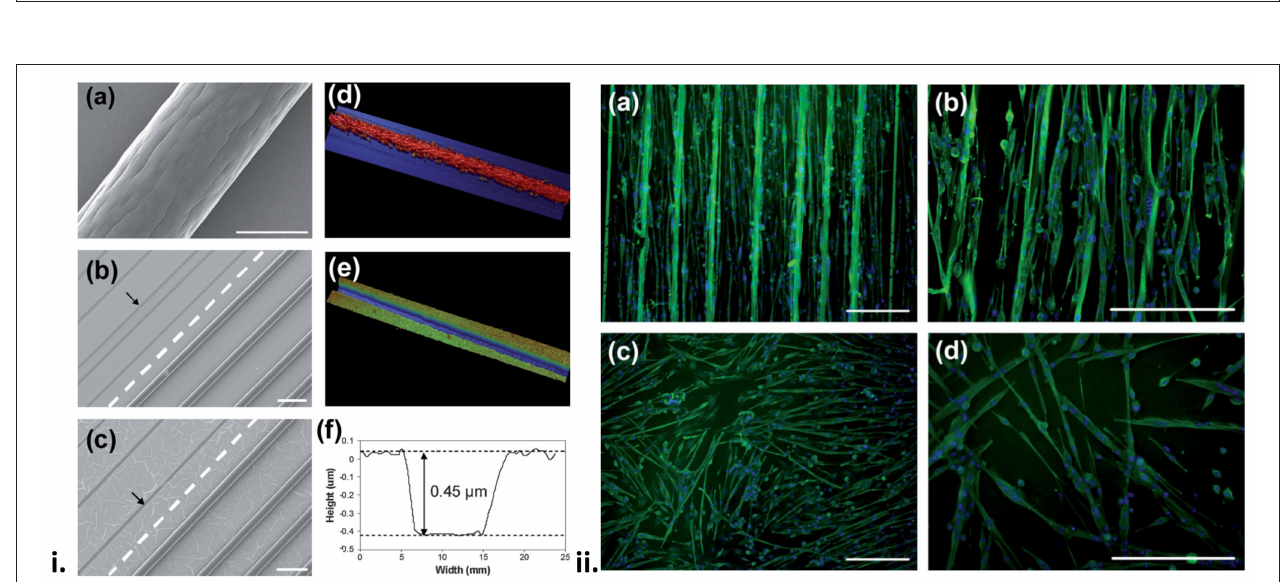
FIGURE 5 | (i) Surface profile of the biosynthetic cell culture platform. Scanning electron microscopy (SEM) images of (a) a 75:25 PLA:PLGA fibre, and (b,c) hybrid platforms made from 75:25 PLA:PLGA fibres and PPy doped with pTS (b) and HA (c) . The broken line separates the area on the PPy substrate where the fibres have been removed (pointed by the arrows). Also shown are profilometry images of the hybrid platform in the (d) presence and (e) absence of PLA:PLGA fibres, and (f) height profile obtained from image (e) . (ii) Fluorescence images of differentiated, multinucleated desmin (green) expressing myotubes on PPy/pTS substrate (a,b) with and (c,d) without the presence of PLA:PLGA fibre array. Cell nuclei are shown in blue. Scale bars are 200mm. Reproduced with permission from Razal et al. (168).